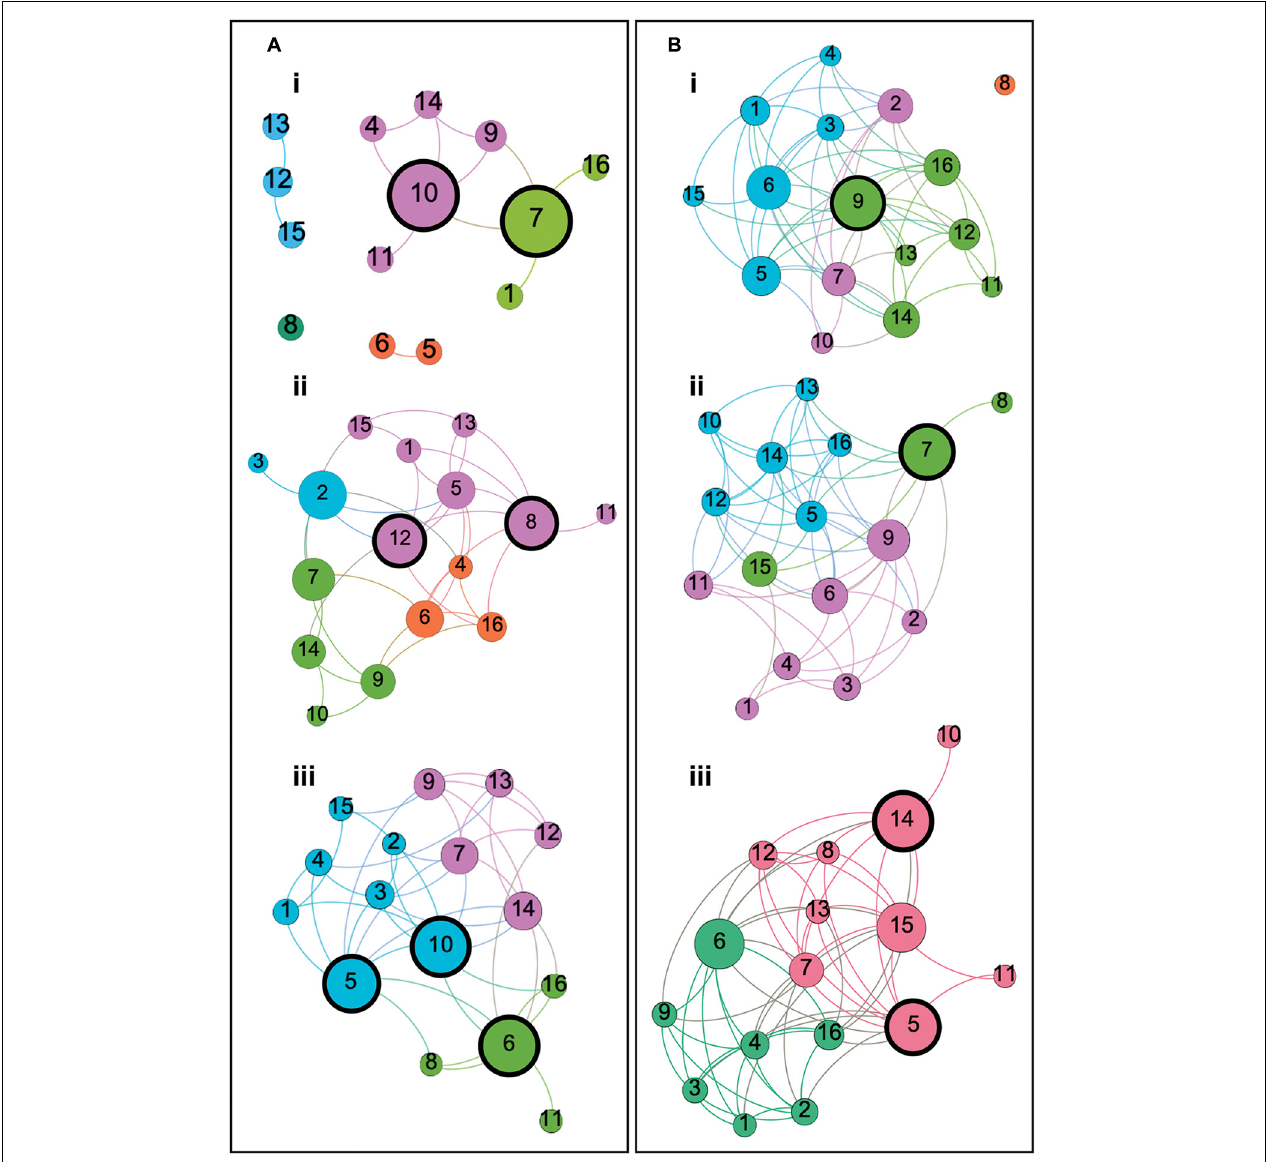
FIGURE 3 | Two dimensional graphs representing the structure of each participant group’s cognitive network. Panels (A) represent the graphs of Young, Middle Aged and Older controls, respectively. Panels (B) represent the graphs of naMCI, aMCI and AD dementia groups, respectively. Each node corresponds to a cognitive test and each edge represents a significant correlation between tests. Color is reflective of modularity class, identified using the Louvain community detection algorithm, and node size is representative of betweenness centrality relative to the individual graph. Modules in each group loosely correspond to cognitive domains described as follows: (Ai) Young controls: Four modules (and one disconnected node) with two modules corresponding to memory and language function (green) and memory and executive function (pink). (Aii) Middle-aged controls: Four modules corresponding to language comprehension and semantic processing (orange), verbal memory and executive functioning (green), recollective memory function (blue) and a less clearly defined module corresponding to multiple domains including memory, language functioning and abstract reasoning (pink). (Aiii) Older controls: Three modules corresponding to episodic memory and visuoconstructive ability (blue), language comprehension and semantic processing (green) and verbal memory and executive functioning (pink). (Bi) naMCI patients: Three heterogeneous modules (and one disconnected node) corresponding to episodic memory, abstract reasoning and visuoconstructive ability (blue), verbal memory and executive function (pink) and attention, executive function, verbal memory and language comprehension (green). (Bii) aMCI patients: Three modules corresponding to language and memory function (pink), semantic processing and visuoconstructive ability (green) and a heterogeneous module including tests of language comprehension, abstract reasoning, verbal memory and executive function (blue). (Biii) Dementia patients: Two modules with one consisting only of tests of language and memory function (green) and another consisting of tests corresponding to any other cognitive domain (red). Nodes are labeled as: 1 = Rey-Osterrieth Complex Figure – Recall, 2 = Prose Memory Test – Immediate Recall, 3 = Prose Memory Test – Delayed Recall, 4 = Verbal Paired Associates Learning Test (WMS), 5 = Raven’s Progressive Matrices, 6 = Similarities (WAIS), 7 = Category Fluency Test, 8 = Confrontation Naming Test, 9 = Letter Fluency Test, 10 = Stroop Test – Time Interference, 11 = Stroop Test – Error Interference, 12 = Digit Span Test – Backward, 13 = Digit Span Test – Forward, 14 = Digit Cancelation Test, 15 = Rey-Osterrieth Complex Figure – Copy, 16 = Token Test.